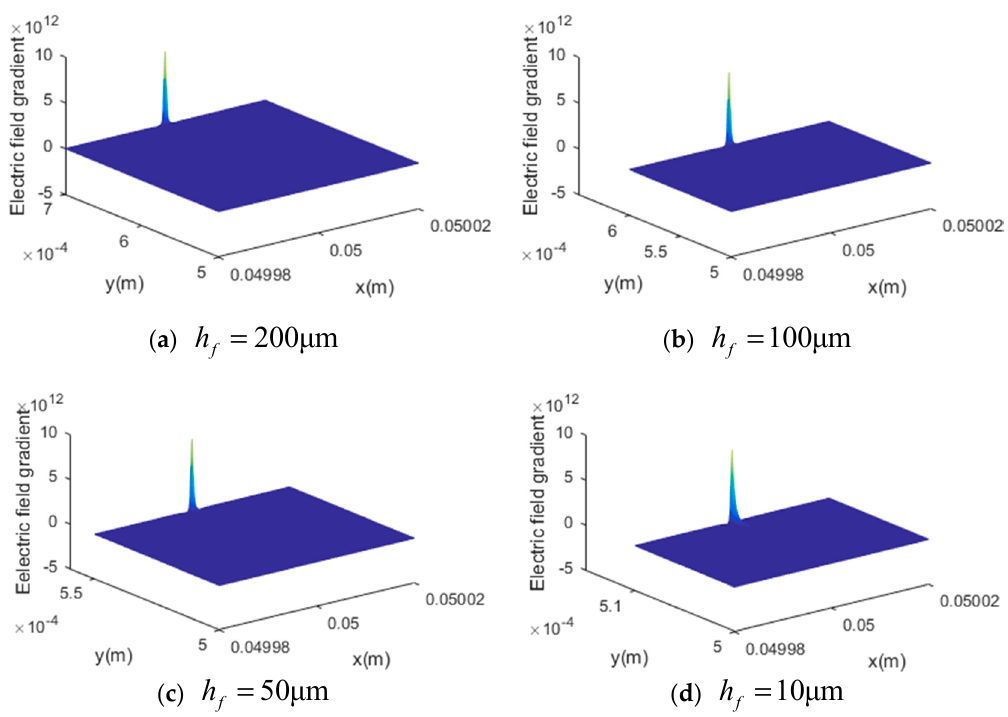
Figure 3. The effect of the flexoelectric layer thickness on the electric field gradient, ( a ) Figure 3. The e ff ect of the flexoelectric layer thickness on the electric field gradient, ( a ) h f = 200 µ m, ( b ) h f = 100 µ m, ( c ) h f = 50 µ m, ( d ) h f = 10 µ